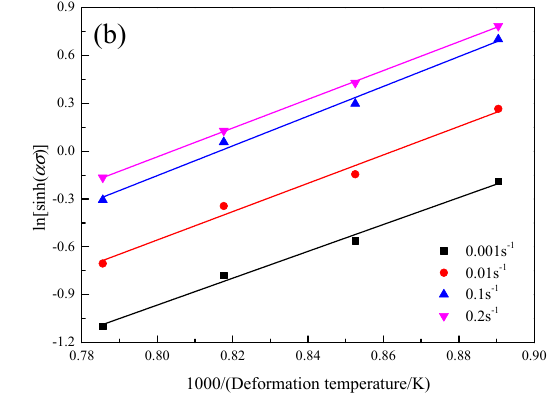
Figure 7. Relationships of ( a ) ln [ sinh ( ασ )] − ln𝜀(cid:4662) ; ( b ) ln(cid:4670)sinh(cid:4666)𝛼𝜎(cid:4667)(cid:4671) − (cid:4666)1000/𝑇(cid:4667) at the true strain of 0.3.